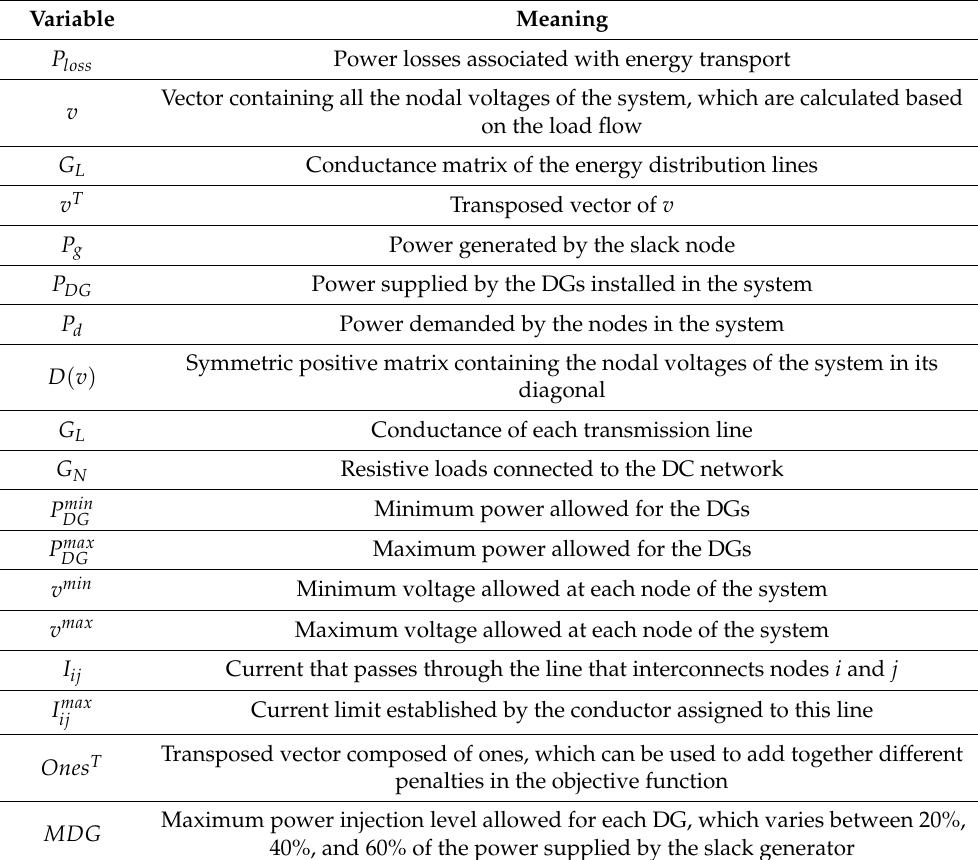
Table 1. Notation